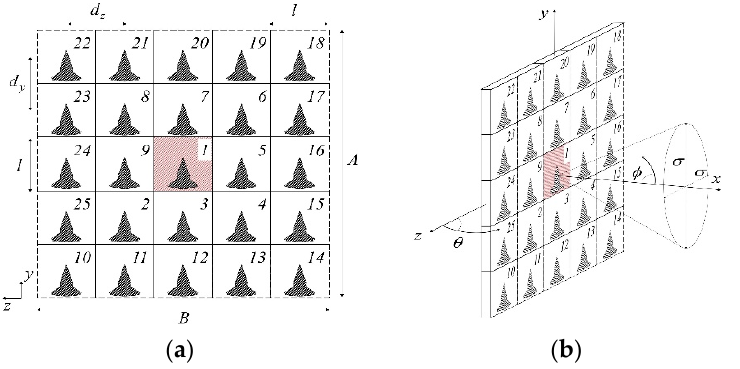
Figure 5. Geometry of the HDI—based filtering 5G patch radiator [35] ( a ) 3D and ( b ) top views.